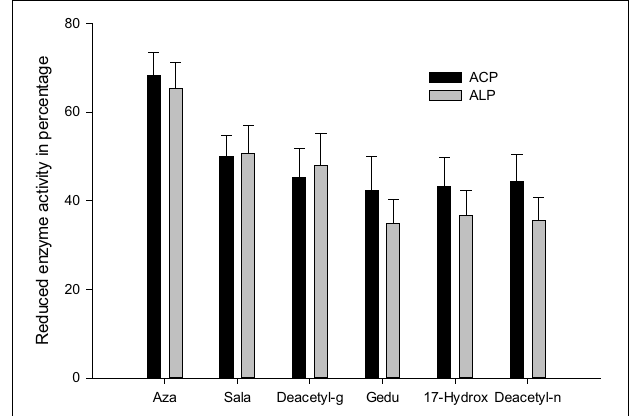
FIGURE 4 | Activity of ACP and ALP against the 1 ppm treatment of azadirachtin on C. medinalis